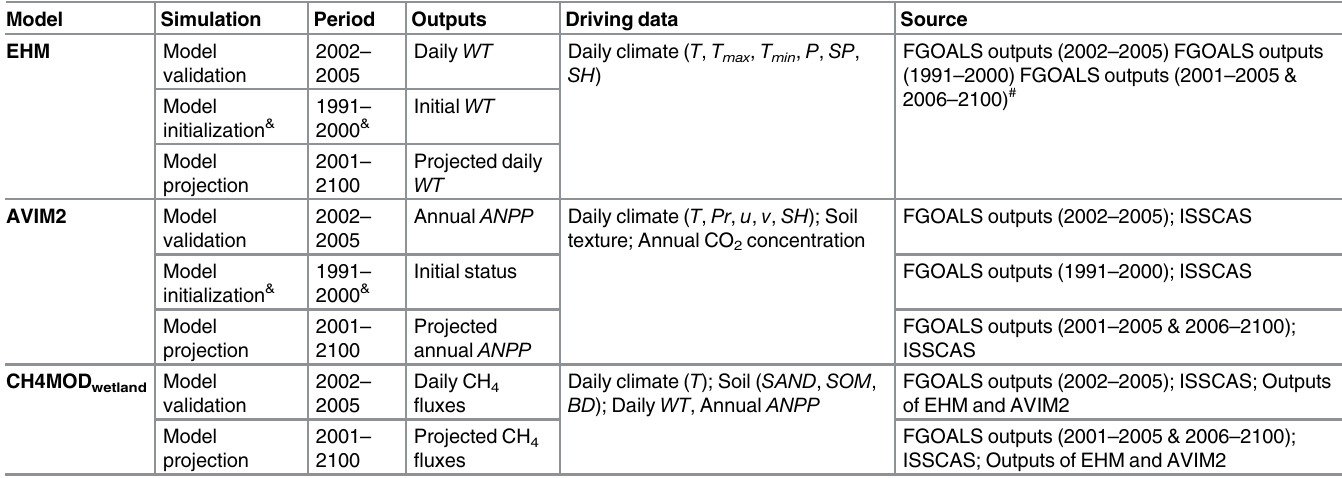
Table 2. Detail description of the model experimental